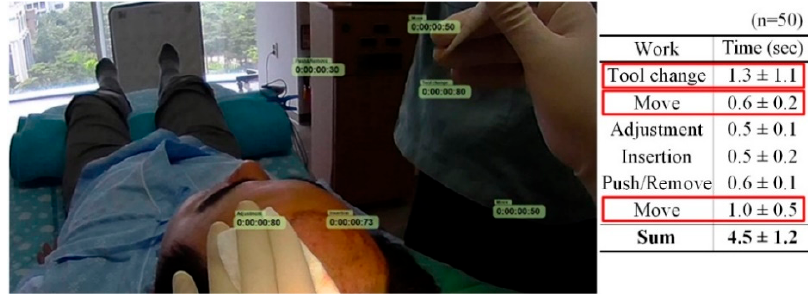
Figure 4. Behavior analysis of hair transplant procedure using manual implanter.